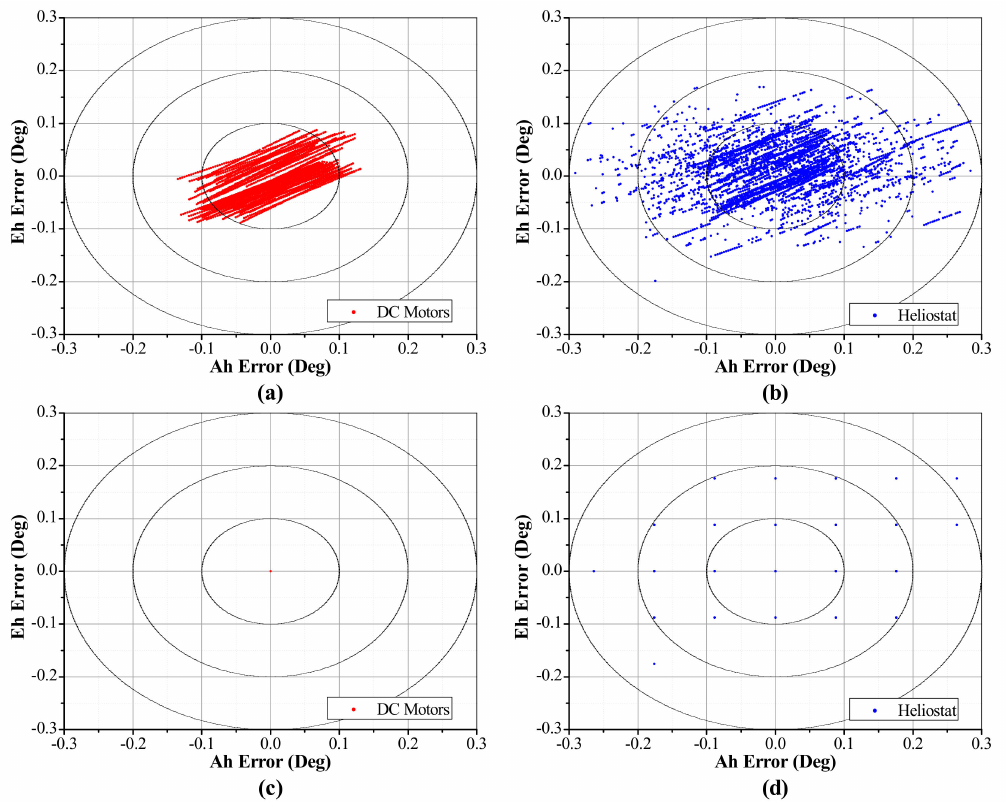
Figure 23. Orientation control response of the heliostat for the azimuth angle ( a ) and the elevation angle ( b ).